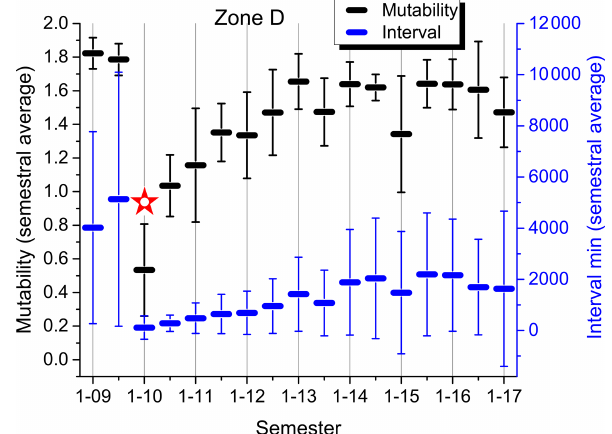
Figure 12. Semestral average of mutability values (upper symbols; black) and intervals in minutes between consecutive seisms (lower symbols; blue) for zone D (Cobquecura). Odd semesters are la- beled on the abscissa axis (1–13; first semester of 2013), while even semesters are only marked. A star identifies a semester with an earthquake with a magnitude over